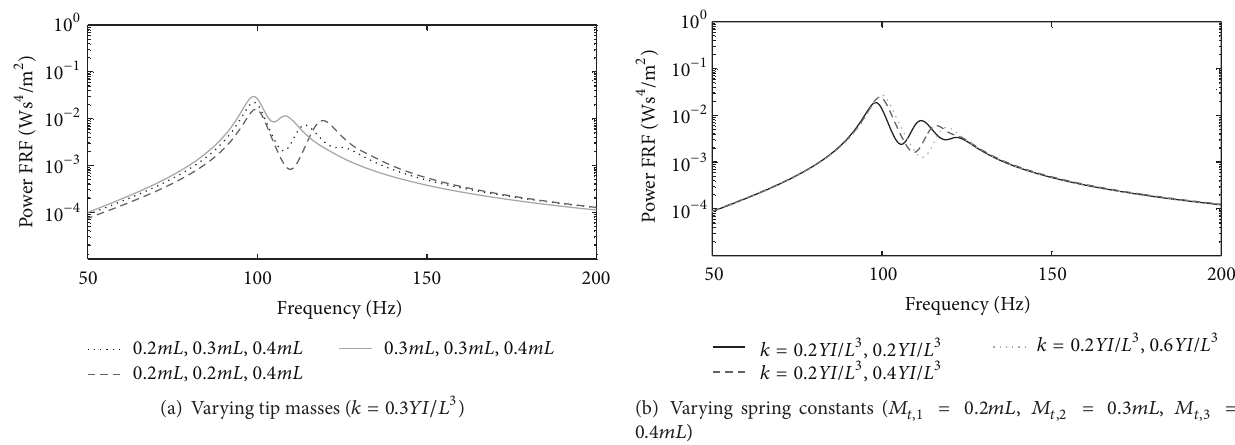
Figure 9: Power FRF of three bimorph beams with different combinations of tip masses and spring constants.